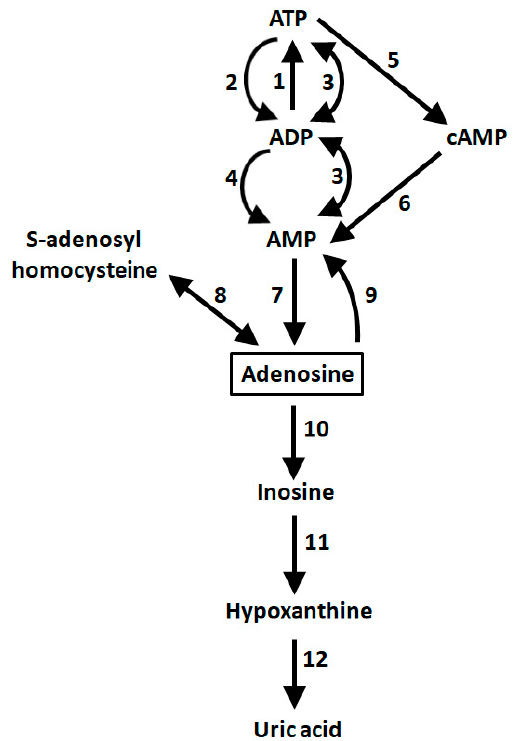
Figure 1. Metabolic pathways involved in the formation and removal of adenosine. 1 = Oxidative phosphorylation (and creatine kinase), 2 = Energy-consuming processes, 3 = Adenylate kinase, 4 = Apyrase, 5 = Adenylate cyclase, 6 = Phosphodiesterase, 7 = 5 ′ -Nucleotidase, 8 = S-adenosyl homocysteine hydrolase, 9 = Adenosine kinase, 10 = Adenosine deaminase, 11 = Purine phosphorylase, 12 = Xanthine oxidase. ATP = adenosine 5’-triphosphate, ADP = adenosine 5’-diphosphate, AMP = adenosine 5’-monophosphate, cAMP = 3’.5’-cyclic adenosine